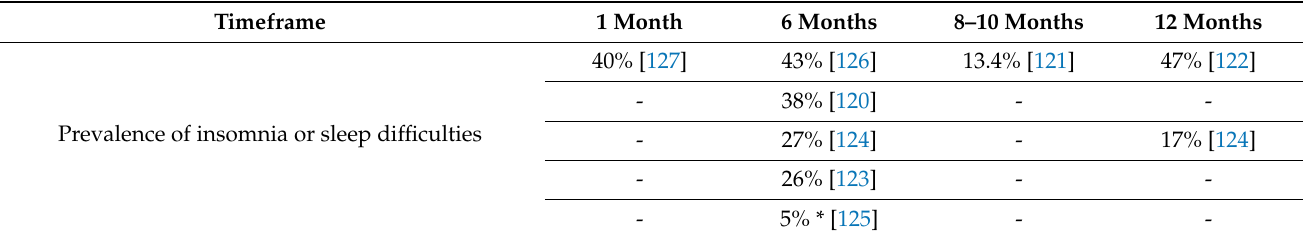
Table 6. The prevalence of insomnia or sleep difficulties during long COVID at different